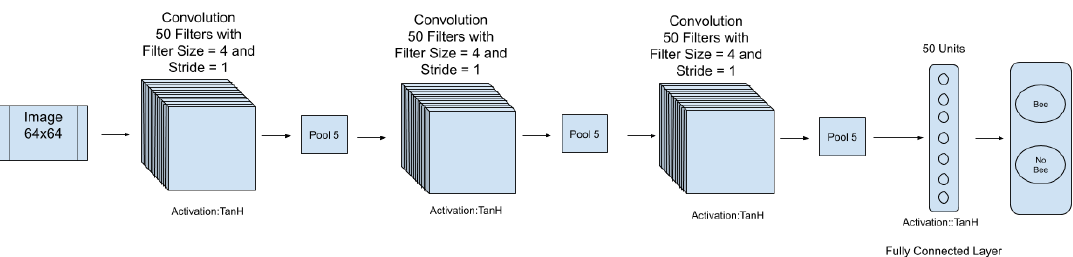
Figure 10. The architecture of ConvNet 1, the best performing hand-designed ConvNet on BEE2_1S (see Table 6).